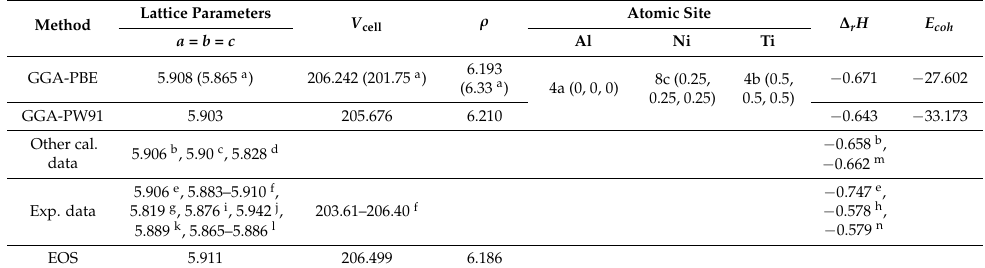
Table 1. The optimized ground-state structural parameters ( a , b , c , in Å; V cell in Å 3 ; ρ in g/cm 3 ), atomic site, cohesive energy ( E coh , eV/f.u.) and formation enthalpy ( ∆ r H , eV/atom) of AlNi 2 Ti intermetallic